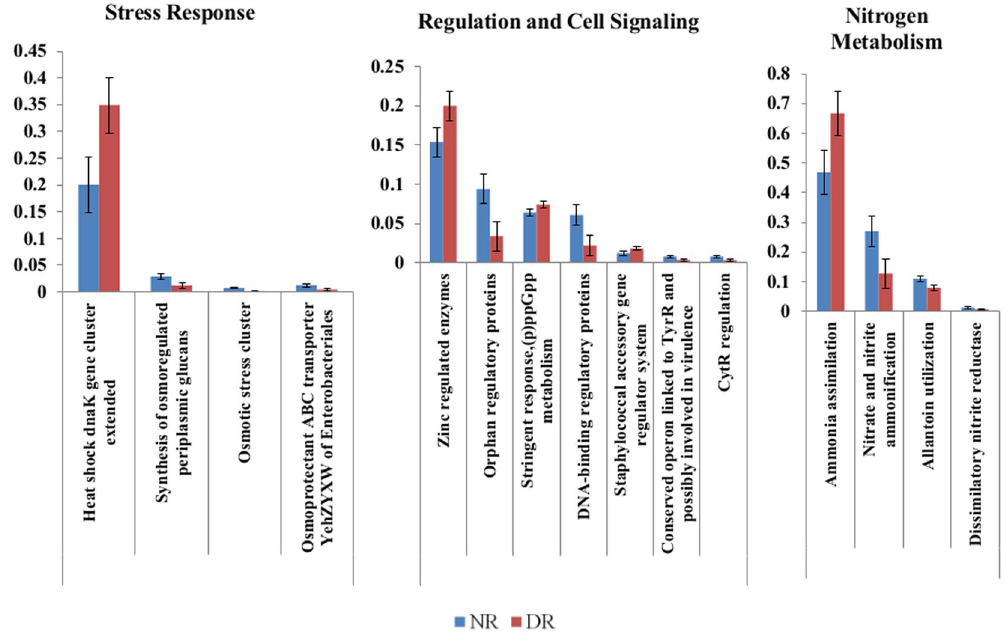
Figure 2. Normalized abundance of gene functions at level 3 for “stress response”, “regulation and cell signaling”, and “nitrogen metabolism”. Results are for samples collected at S1. Only functions for which a significant difference between DR and NR samples was detected were included in the table ( P < 0.05). Error bars are standard error of the